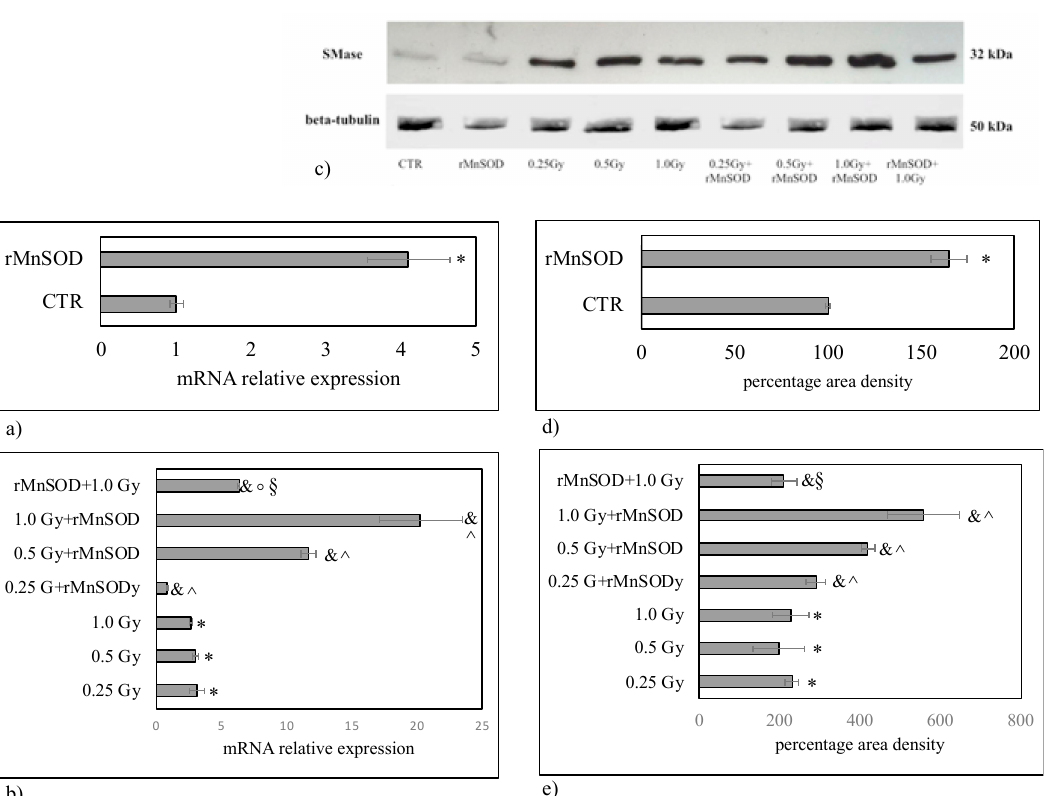
Figure 3. Effect of rMnSOD on nSMase gene and protein expression. Samples from mice treated with 0.25, 0.5 and 1.0 Gy radiation doses, in the presence or absence of rMnSOD. rMnSOD + 1.0 Gy: mice pretreated with rMnSOD, exposed to a 1.0 Gy radiation dose, then treated with rMnSOD for 3 days. Left panels ( a , b ): RTqPCR analyses. GAPDH was used as housekeeping control gene. Data are expressed as mean ± SD of mRNA expression (folds increase). Top panel ( c ): immunoblotting analysis of nSMase; tubulin was used as control. Right panels ( d , e ): immunoblotting densitometric analysis, normalized with beta-tubulin. Data are expressed as the mean ± SD of 3 independent experiments, each carried out in triplicate. Significance: ( a , d ) not-irradiated rMnSOD-treated samples compared to not-irradiated and not-rMnSOD-treated samples (CRT) (* p < 0.05); ( b , e ): irradiated not-rMnSOD-treated samples and irradiated rMnSOD-treated and pretreated samples. Irradiated samples compared to CTR samples (* p < 0.05), irradiated and rMnSOD-treated and pretreated samples vs. rMnSOD-treated samples (& p < 0.05), irradiated and rMnSOD-treated samples vs. their correspondent irradiated samples (^ p < 0.05), rMnSOD-pretreated and 1.0 Gy irradiated sample vs.1.0 Gy irradiated sample (° p < 0.05), rMnSOD-pretreated and 1.0 Gy irradiated sample vs.1.0 Gy irradiated and rMnSOD-treated sample (§ p < 0.05).